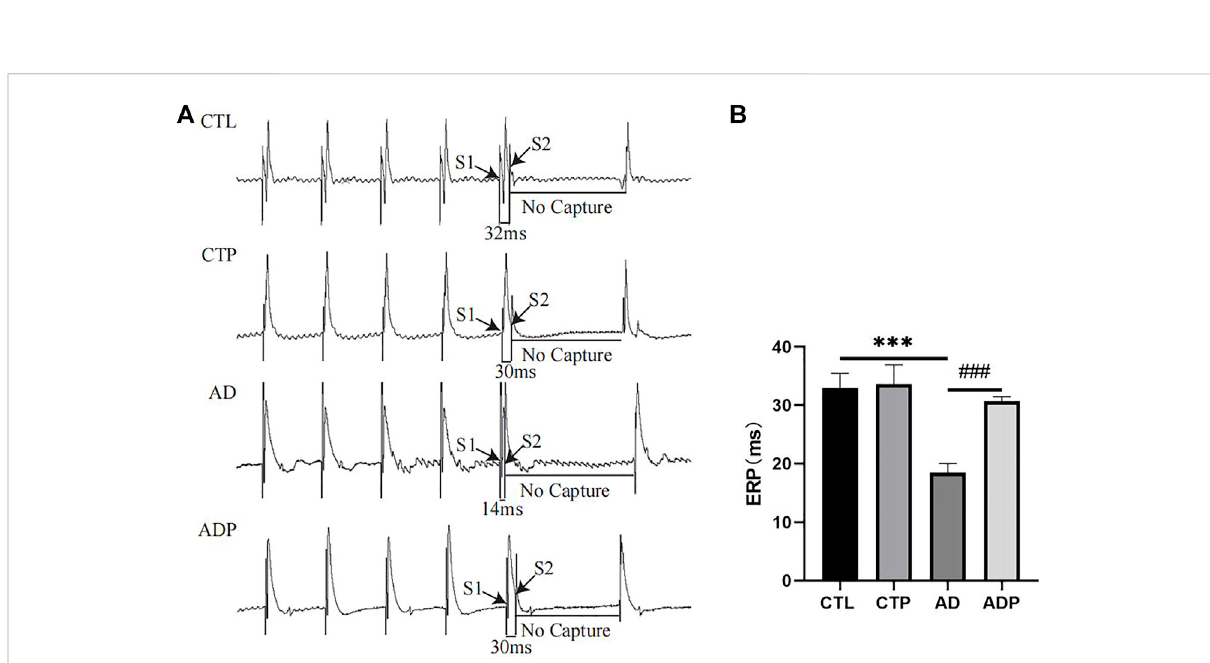
FIGURE 4 Effective refractory period. (A) TypicalatrialERPsatPCLof200 ms. (B) Average ERP. n =7pergroup. * p < 0.05, ** p < 0.01,*** p < 0.001 vs.CTL; # p < 0.05, ## p < 0.01, ### p < 0.001 vs.